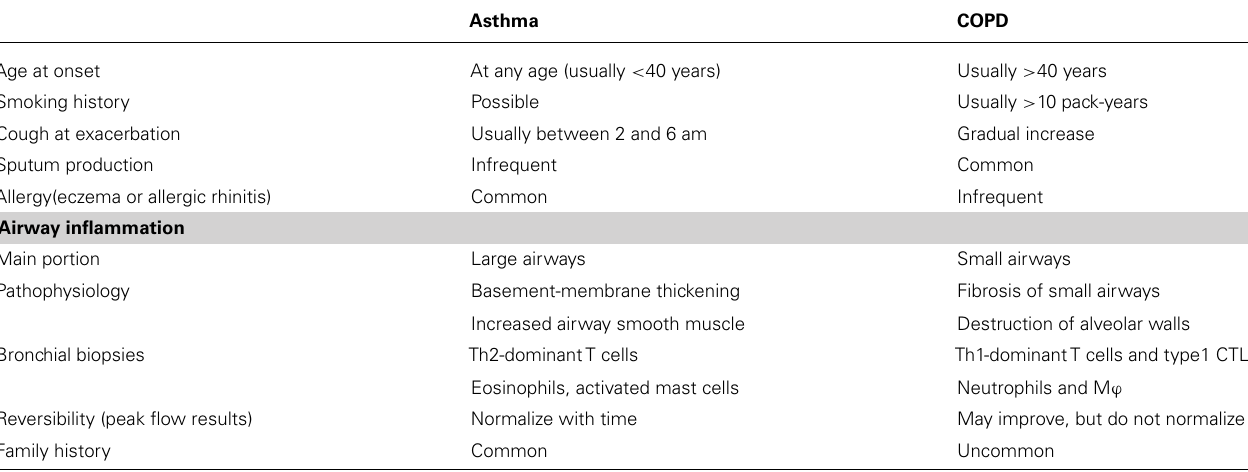
Table 1 | Differences between asthma and